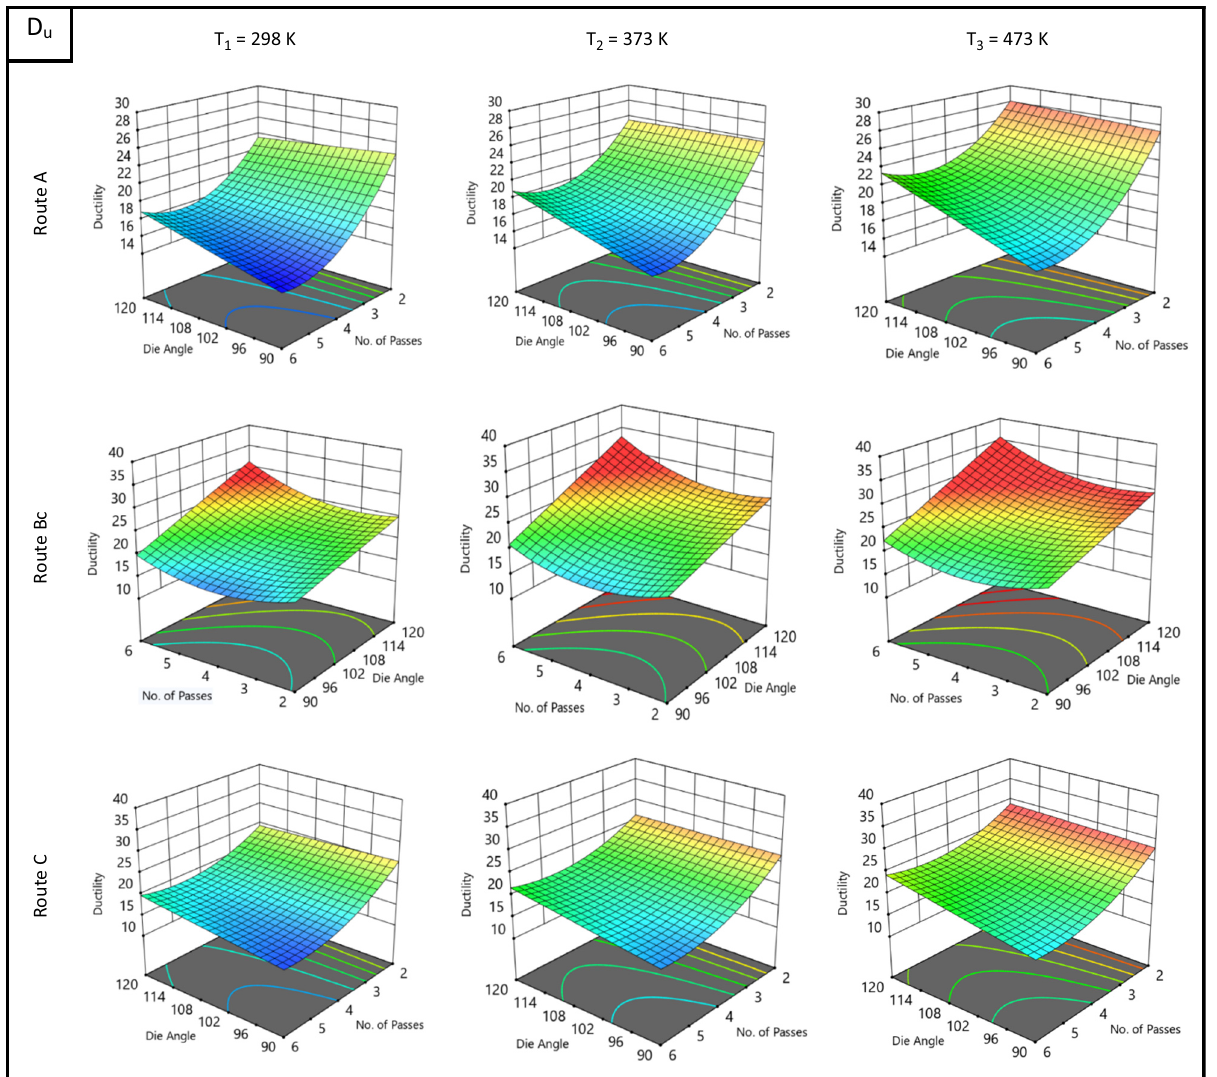
Figure 16: Response surface plot of D u as a function of die angle, number of passes, route type, and processing